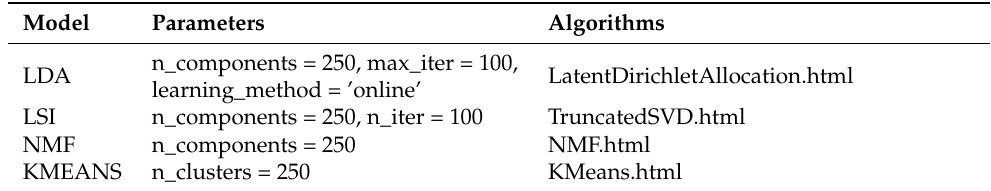
Table 3. Hyperparameters for k-means, LSI, NMF, and LDA algorithms.